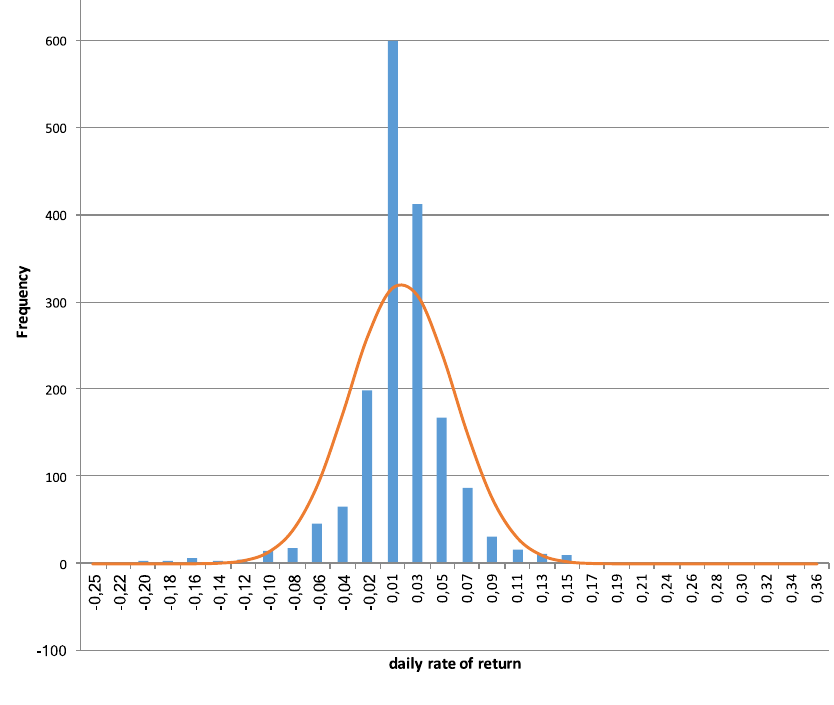
Figure 5. Histogram of daily returns on the BitFinex stock market – selection based on the capitalization value as of December 15, 2017 (1,706 quotations in the period